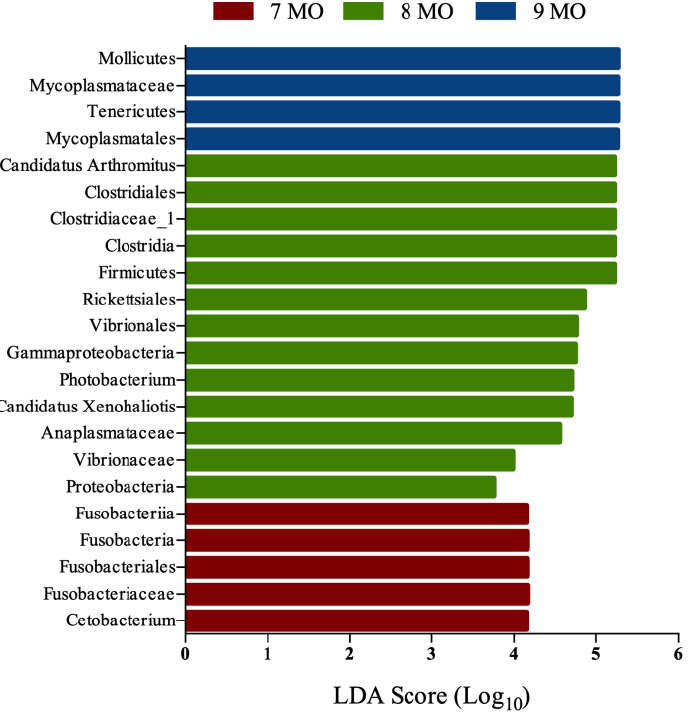
Figure 2. LEfSe identified the differentially abundant taxa among sampling time. The histogram shows the linear discriminant analysis (LDA) scores computed for different level taxa, based on their relative abundance in the intestinal microbiota of Seriolella violacea .